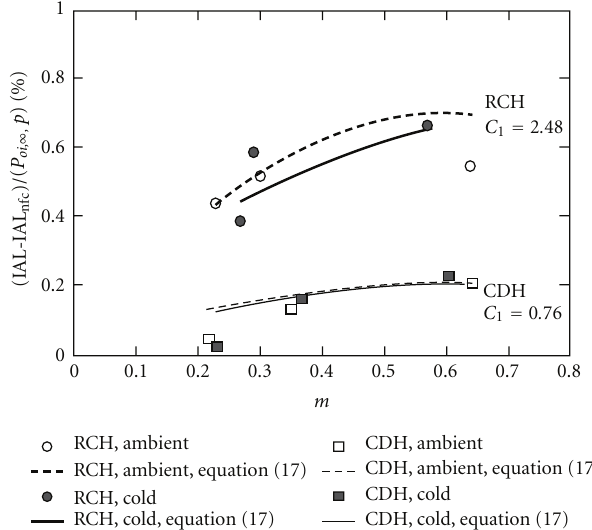
Figure 11: Comparison of normalized integrated aerodynamic losses relative (minus-integrated aerodynamic losses with no film cooling) at di ff erent blowing ratios (after correction for the presence of trailing edge oblique shock waves) with correlating equation (17) for the symmetric airfoil with film cooling